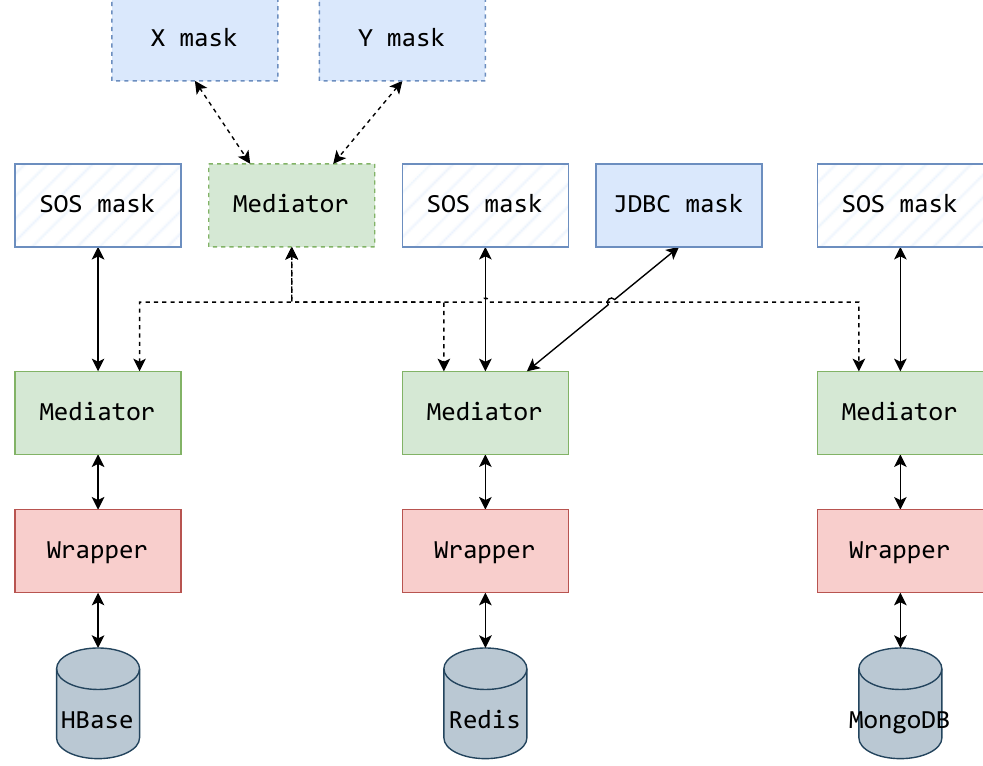
Figure 17. The SOS system implemented in the MMW